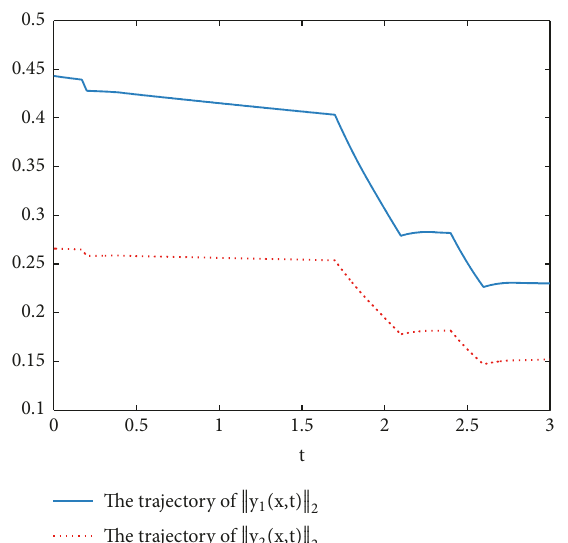
Figure 1: The open-loop trajectories of ‖𝑦 1 (𝑥,𝑡)‖ 2 and ‖𝑦 2 (𝑥,𝑡)‖ 2 .